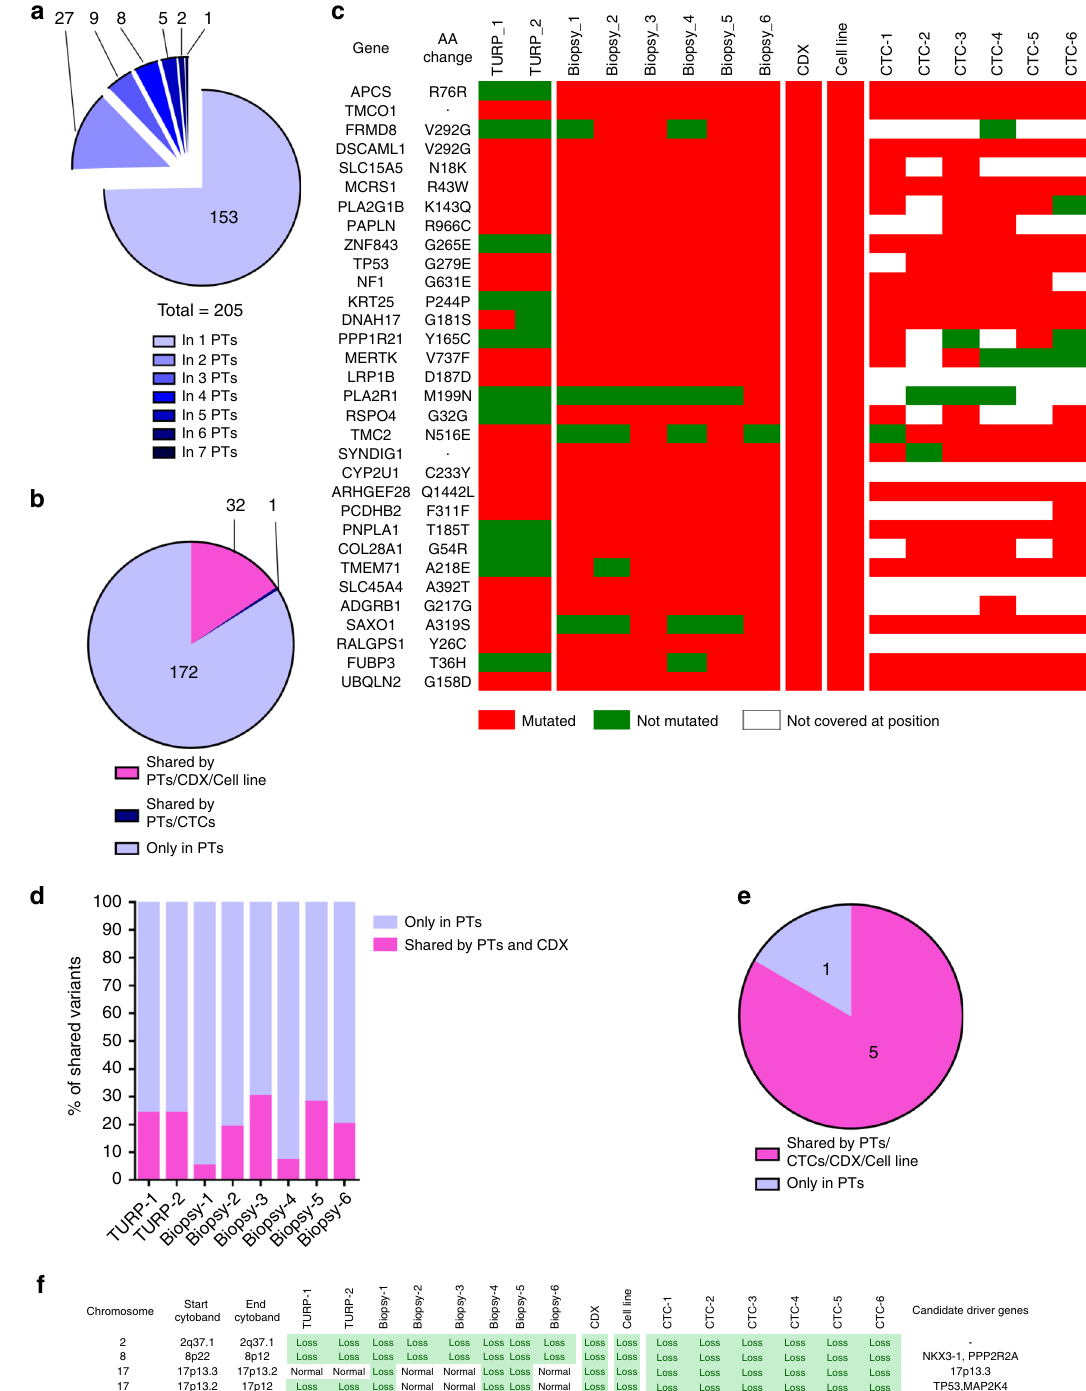
RAD51, PALB2, FANCA, CHEK2, MLH1, MSH2, MLH3 ,